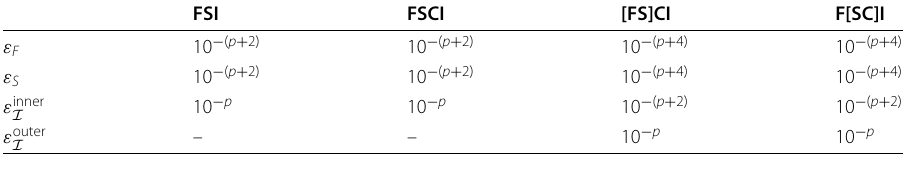
Table 2 Recommendation for the numerical accuracy of solvers and interface iterations